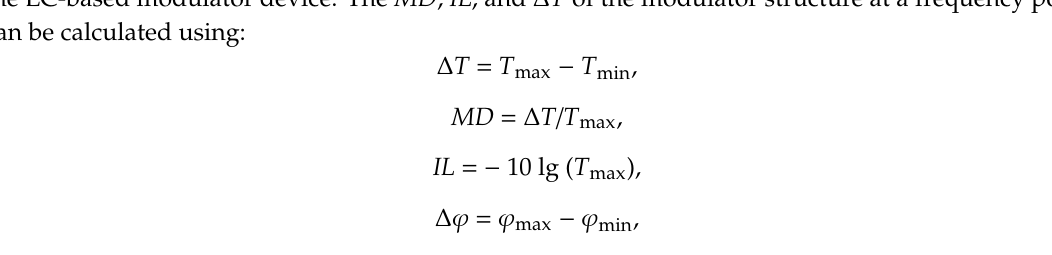
5 of 10 Figure 3. Simulated transmittance spectra for different dielectric constants.